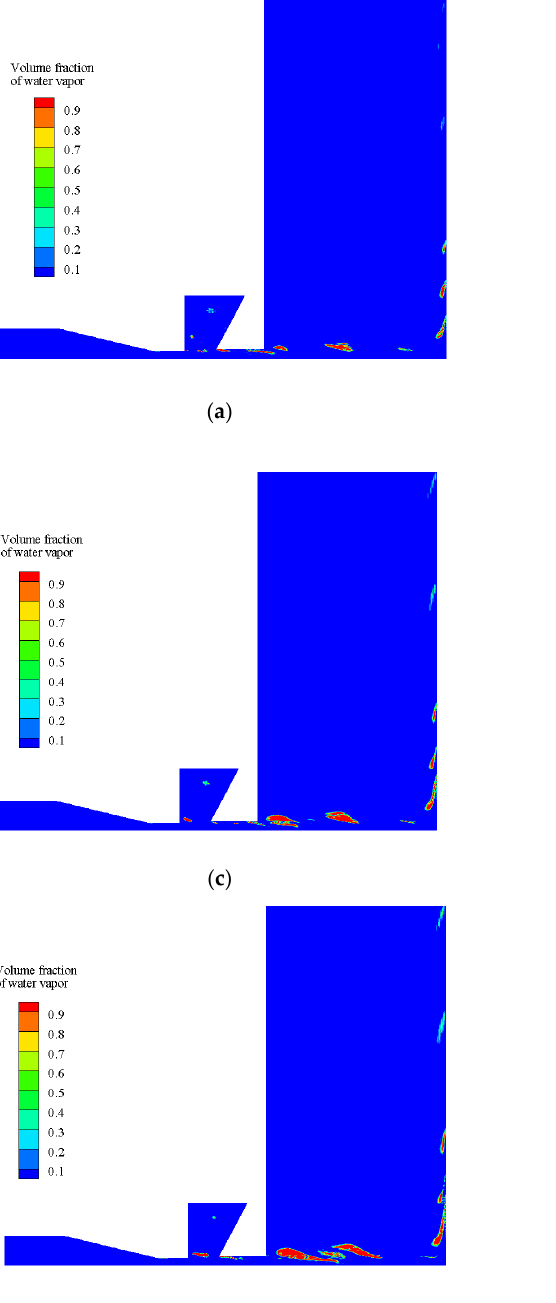
Figure 11. Time evolution of water vapor volume fraction. ( a ) t = t 0 + 0 ms; ( b ) t = t 0 + 10 ms; ( c ) t = t 0 + 20 ms; ( d ) t = t 0 + 30 ms; ( e ) t = t 0 + 40 ms; ( f ) t = t 0 + 50 ms.